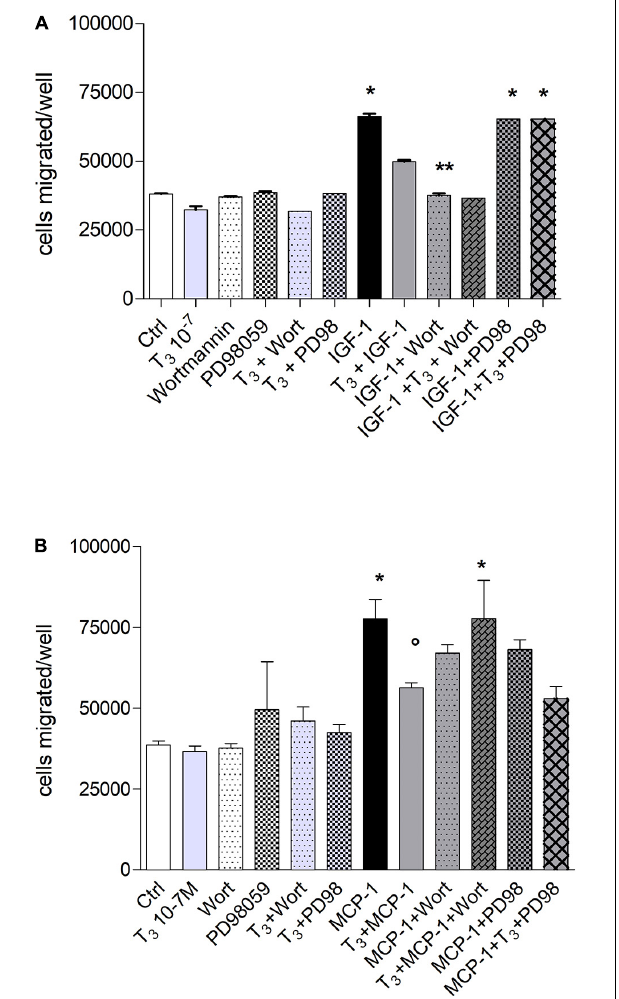
FIGURE 5 | Effect of T 3 (10 − 7 M) on the migration of THP-1 cells induced by either insulin-like growth factor-1 (IGF-1) (A) or monocyte chemoattractant protein 1 (MCP-1) (B) . PD98059 (10 µ M) and wortmannin (100 nM) were preincubated 20 min before adding T 3 (10 − 7 M) and MCP-1 (100 ng/ml). Results are reported as mean ± SD of n = 2–4 different experiments carried out in duplicate. (A) * p < 0.05, at least, vs. the others; ** p < 0.001 vs. T 3 + IGF-1; (B) * p < 0.05 at least, vs. all the others but MCP-1 + PD98059; ◦ p < 0.05 vs. MCP-1 + T 3 + Wort and vs.